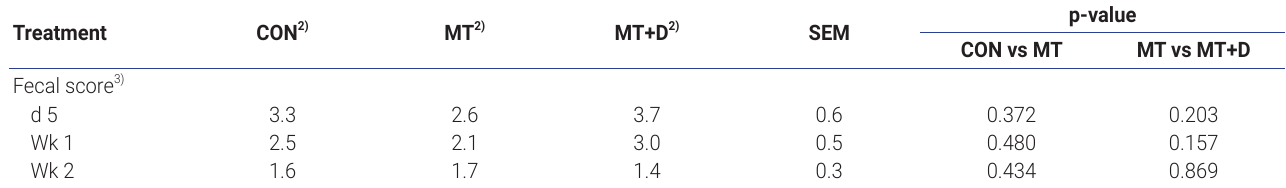
Table 5. Fecal score recorded in weaned pigs consuming experimental diets with (MT 1) ) or without mycotoxins (CON) at d 5, end of week 1, and end of week 2 Treatment